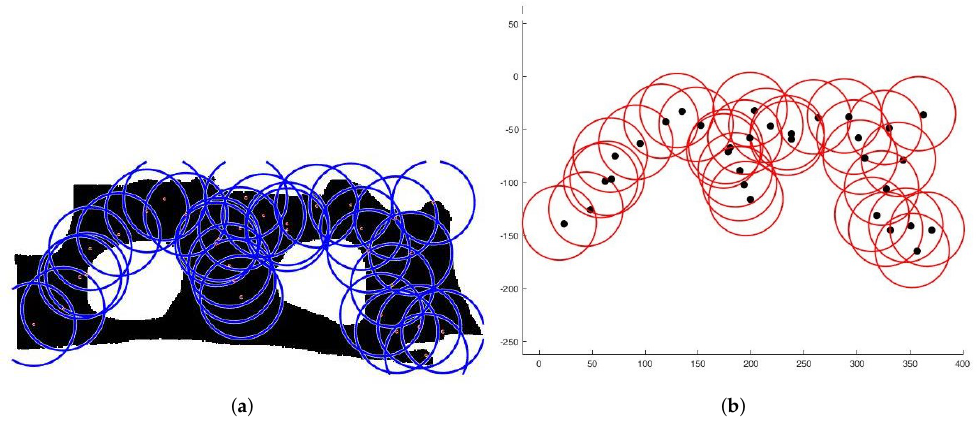
Figure 14. Deployment with two “no interest” area. ( a ) Final positioning. ( b ) Connectivity